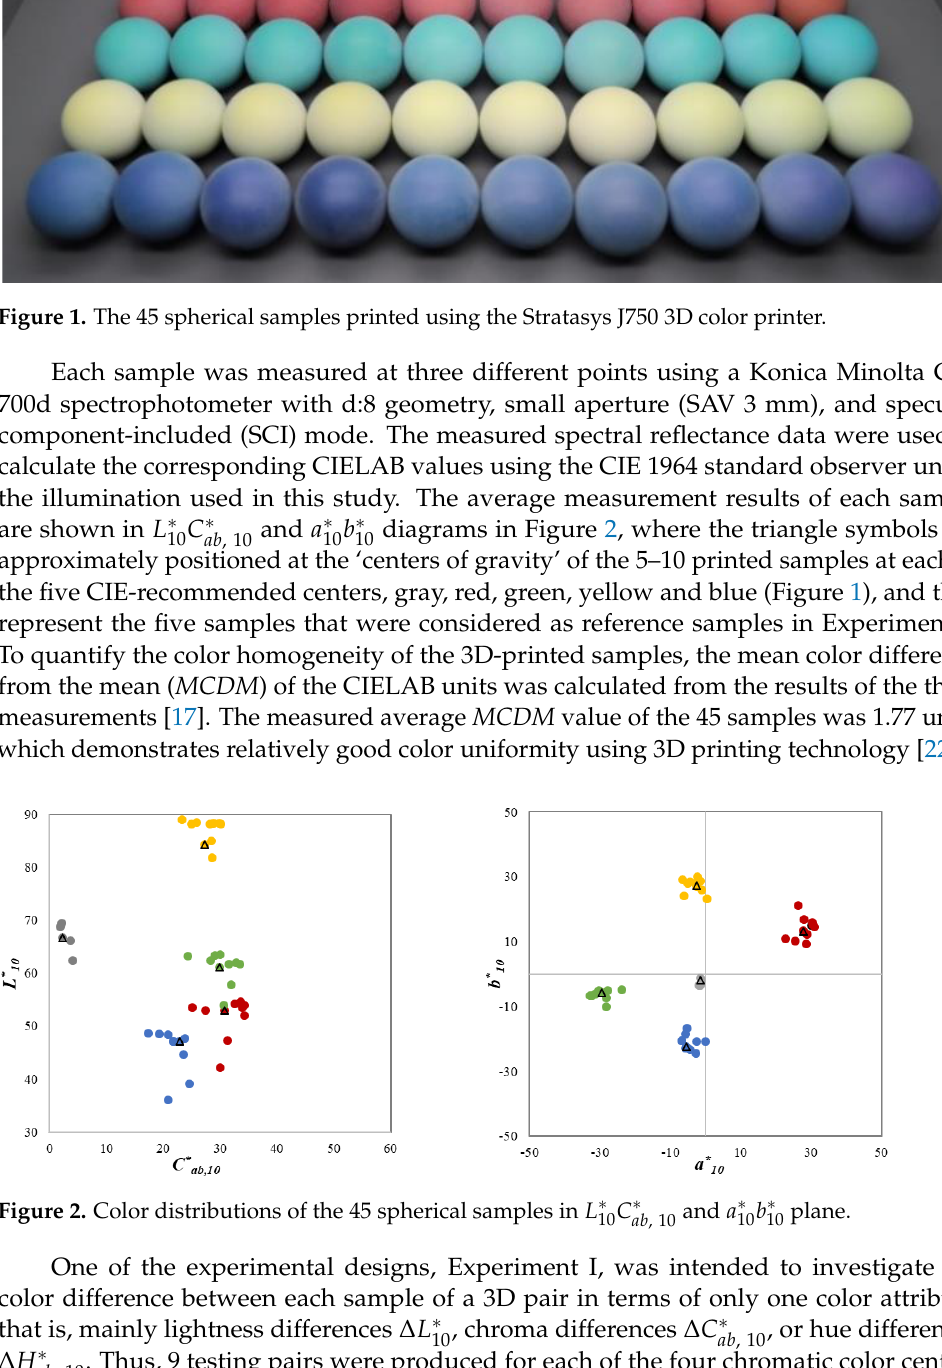
printer, the 45 colors were printed with resins and 45 spherical samples with a diameter of 50 mm were prepared, as shown in Figure 1.